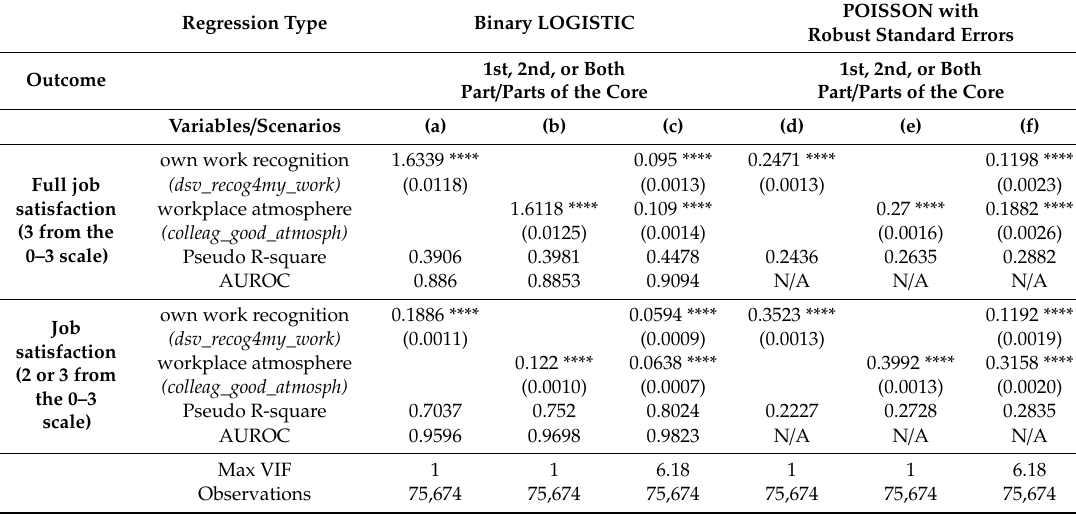
Table 5. Testing the strongest influences (dual-core) for a European model of predicting job satisfaction in terms of average marginal e ff ects by following a pessimistic and unbalanced approach of treating missing values (0 to 3 scale, where 0, which indicates a strong disagree, is also used for missing, undecided answers and unwillingness to